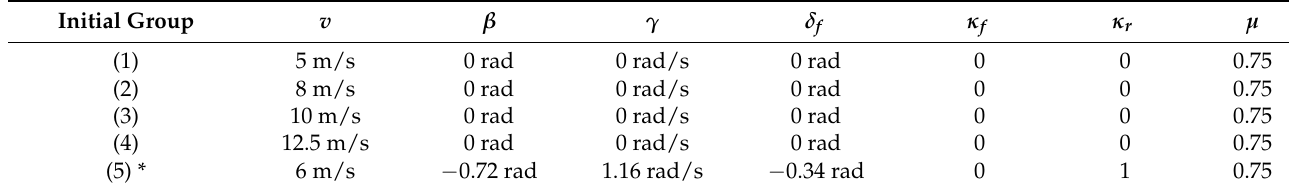
Table 3. Initial motion